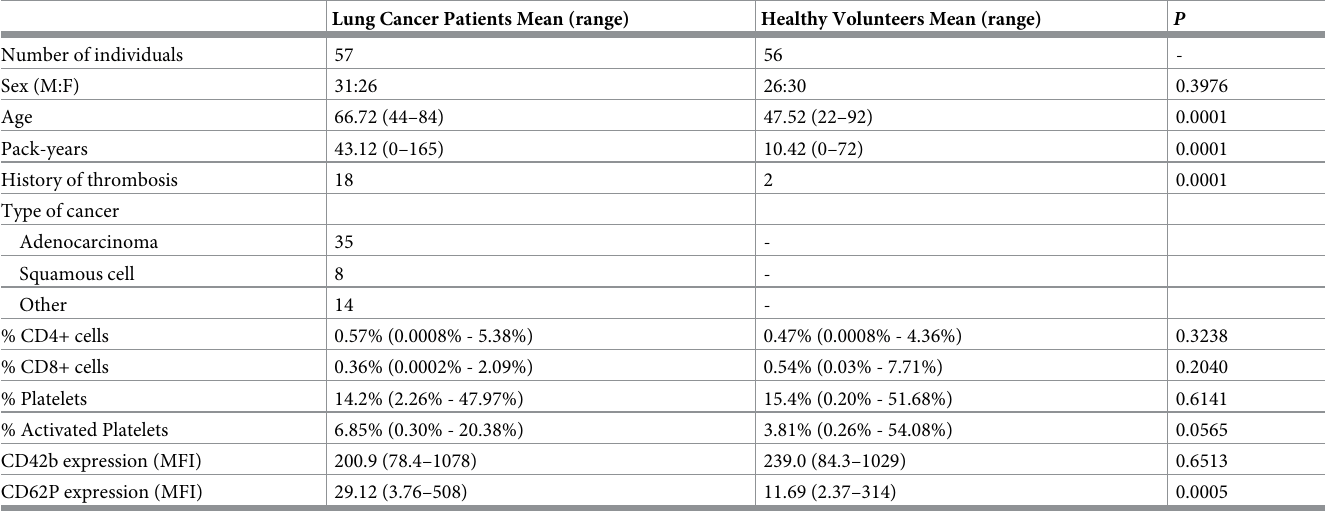
Table 1. Clinical characteristics of enrolled individuals. Lung Cancer Patients Mean